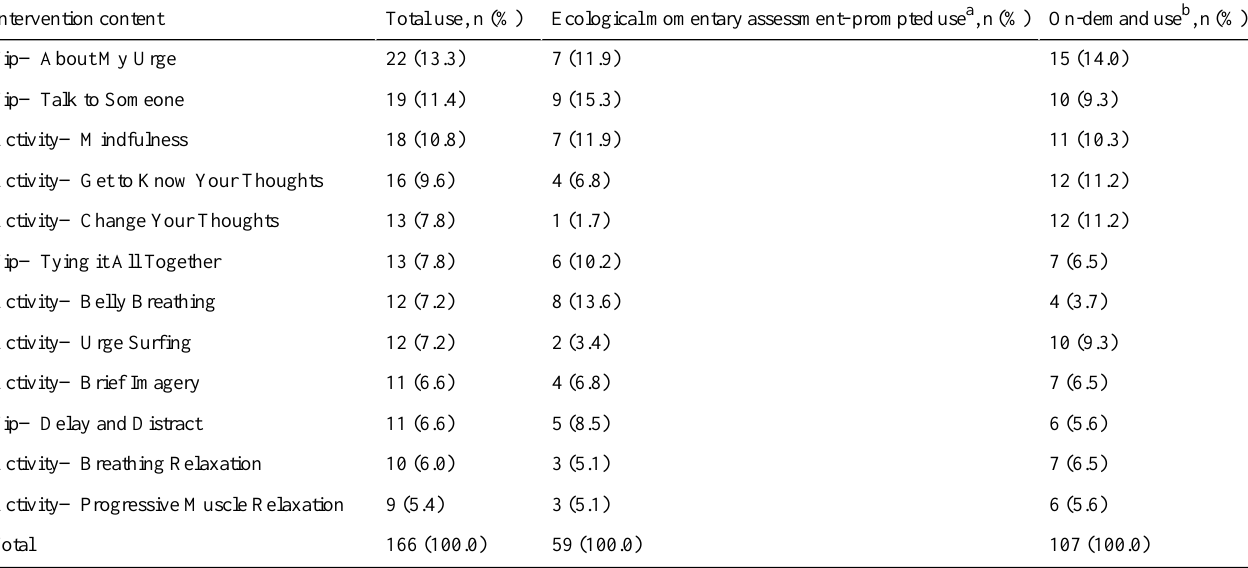
Table 3. Total intervention use frequencies (count and percentages) stratified by ecological momentary assessment–prompted and on-demand use during the 4-week intervention period